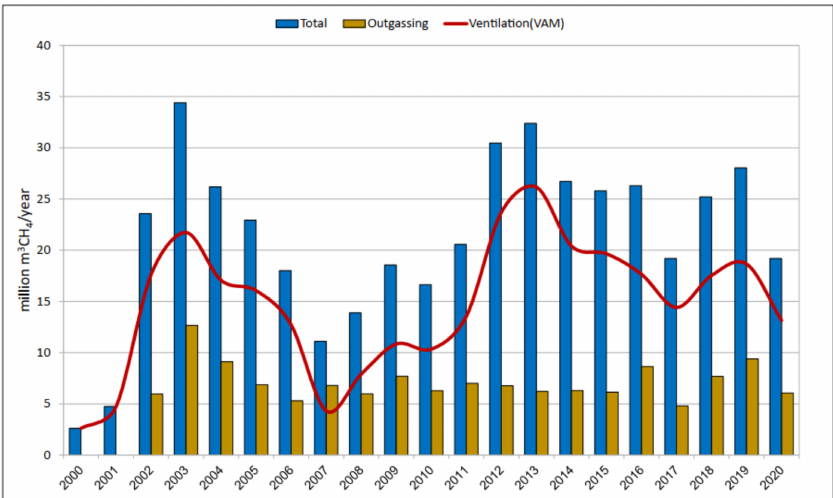
Figure 9. Total methane emissions and outgassing and ventilation air methane from 2000–2020 in the Rydułtowy mine.